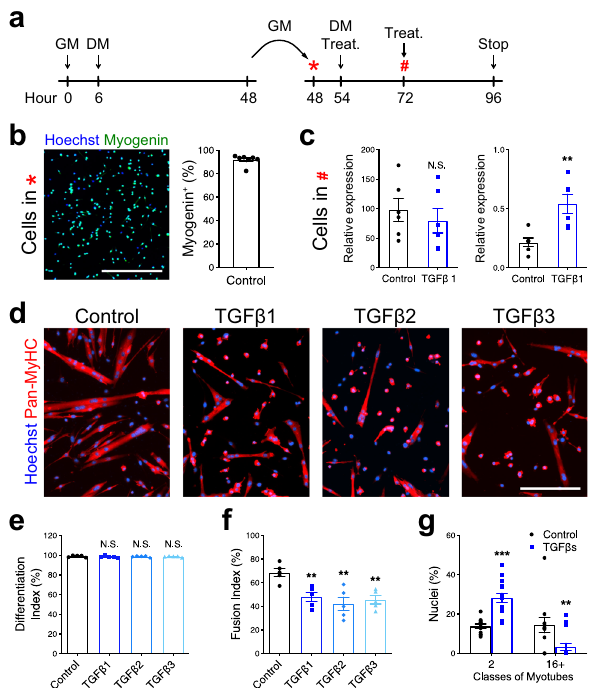
Fig. 3 TGF β signaling limits cell fusion. a Experimental scheme. Primary myoblasts seeded at low density (5000 cells/cm 2 ) were differentiated for 2 days, split, and re-plated at high density (75,000 cells/cm 2 ) and cultured for 2 more days. b Immuno fl uorescent staining for MYOGENIN of primary myocytes pre-differentiated for 48 h and re-plated at high density con fi rms that >90% of cells express Myogenin. N = 7 biologically independent experiments. c qRT-PCR analysis for Myogenin and Smad7 transcript expression of re-plated primary myocytes cultured for 24 h with or without TGF β 1 recombinant protein. Although TGF β 1 stimulation activates Smad7 expression, it does not affect Myogenin transcript levels. N = 6 primary cell cultures. d Immuno fl uorescent staining for the MYOSIN HEAVY-CHAIN isoforms (Pan-MyHC) of re-plated primary myocytes cultured for 48 h. e Percentage of Pan-MyHC-expressing cells of re-plated myotubes shows that cells were differentiated in all conditions. N = 5 biologically independent experiments. f Fusion index of re-plated myotubes reveals that TGF β stimulation inhibits fusion. N = 5 biologically independent experiments. g Percentage of nuclei in the smallest and largest myotube classes. TGF β -treated myotubes are characterized by less nuclei per myotube. N = 11 (control) and 15 (TGF β 1) biologically independent experiments. Scale bars: b 400 μ m; d 200 μ m. Data are presented as mean ± SEM. Unpaired two-tailed Student ’ s t tests were used to compare between data. ** and *** denote a signi fi cant difference with the Control group of P < 0.01 and P < 0.001, respectively. NS not signi fi cant. Source data are provided as a Source Data fi